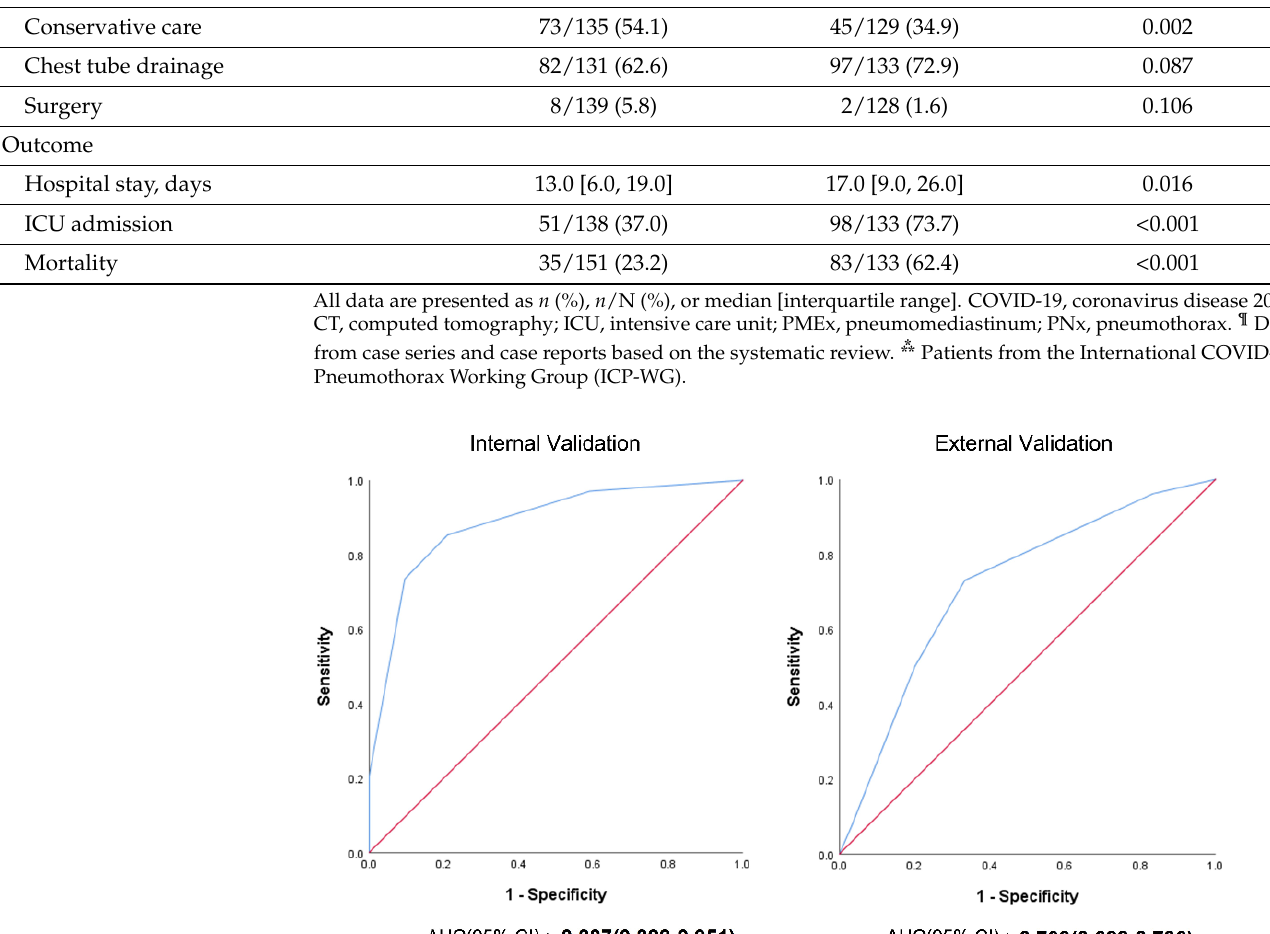
Figure 1. Probability of in ‐ hospital mortality according to the CoBiF score.